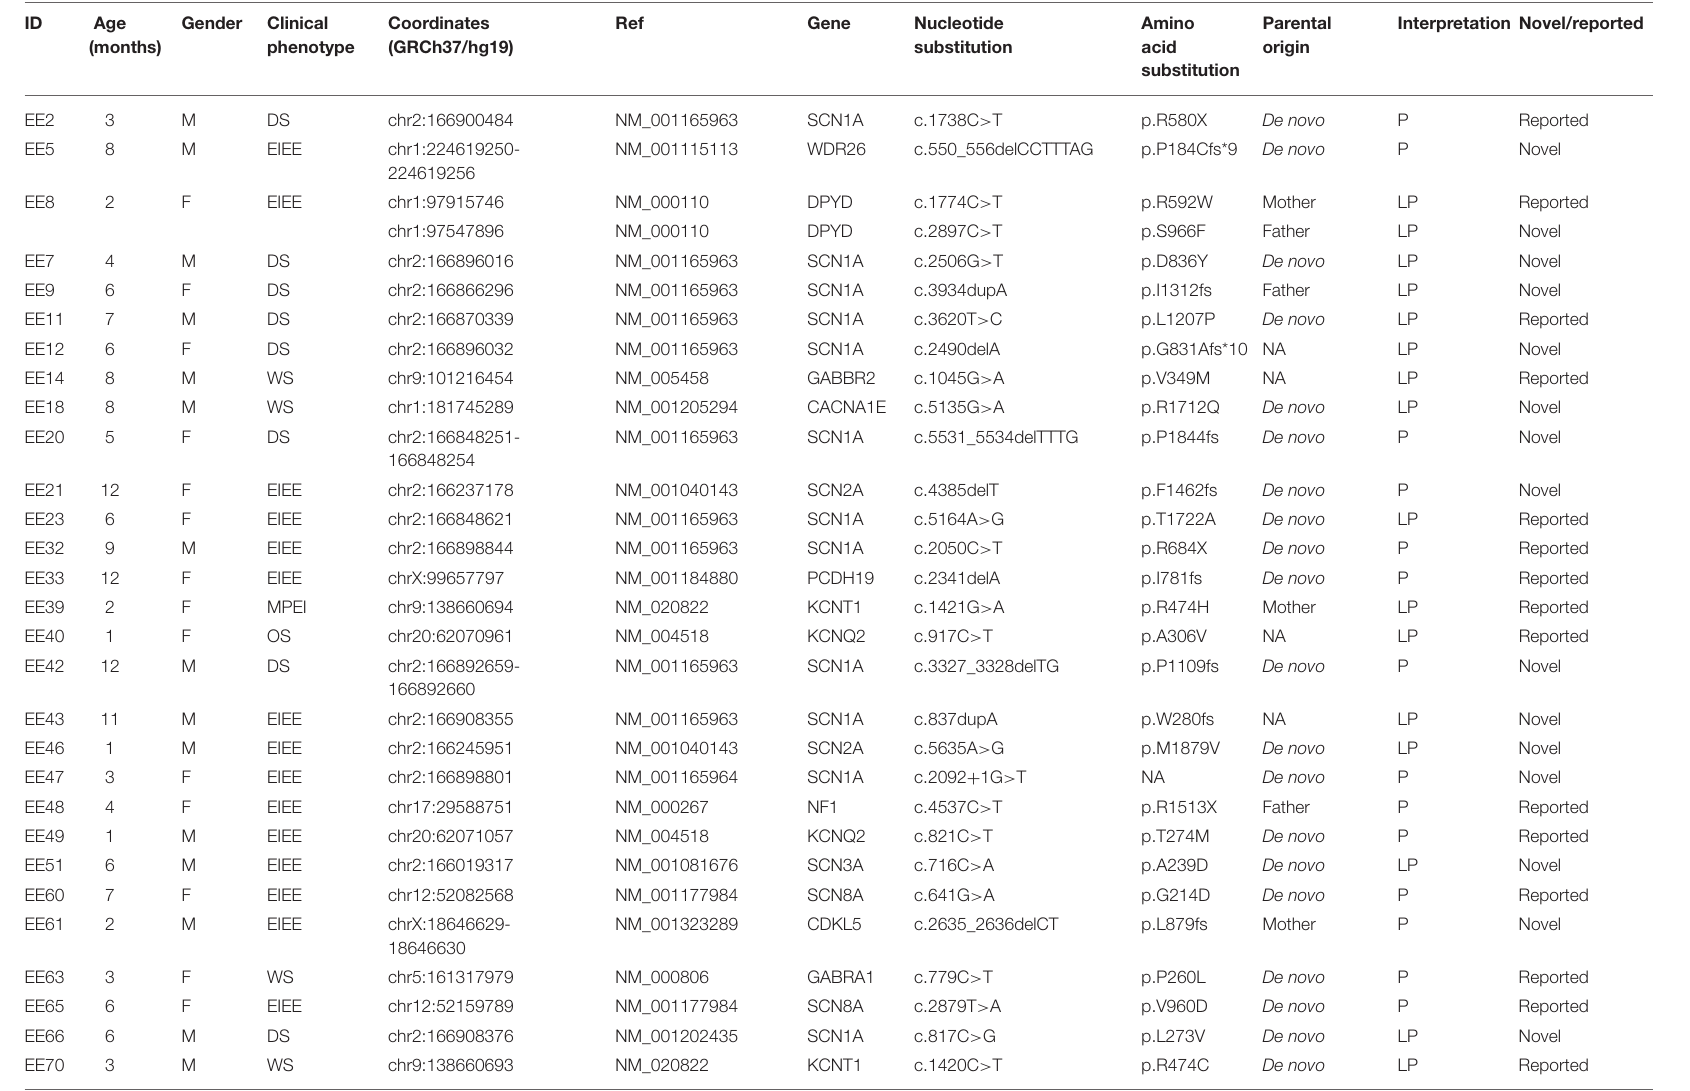
TABLE 2 | Profiles of identified pathogenic or likely pathogenic sequence variants in the patients with